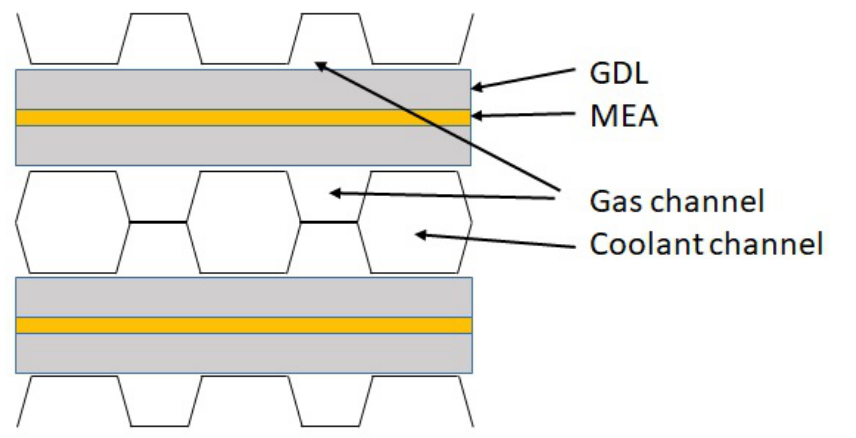
Figure 2. Cross section of two neighboring cells with resulting coolant channels in the